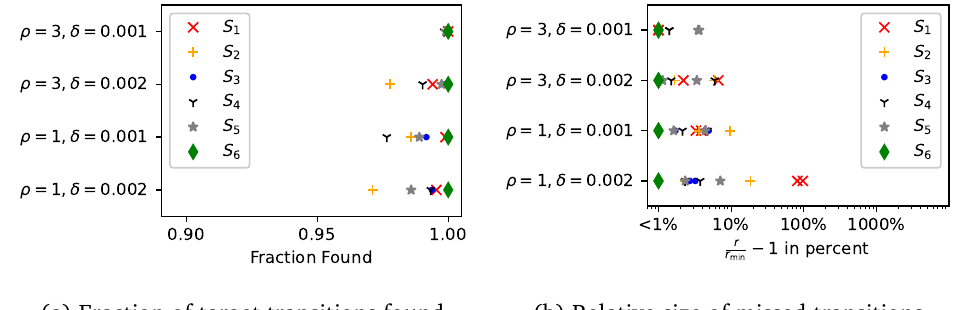
Figure 6: Success rate of the algorithm for computing P found. We take only facets of the polytope into account that are included in T (e.g., "all one-electron transitions") and would be selected by the stopping criterion. Right: for missed facets, we measure the relative size compared to our stopping